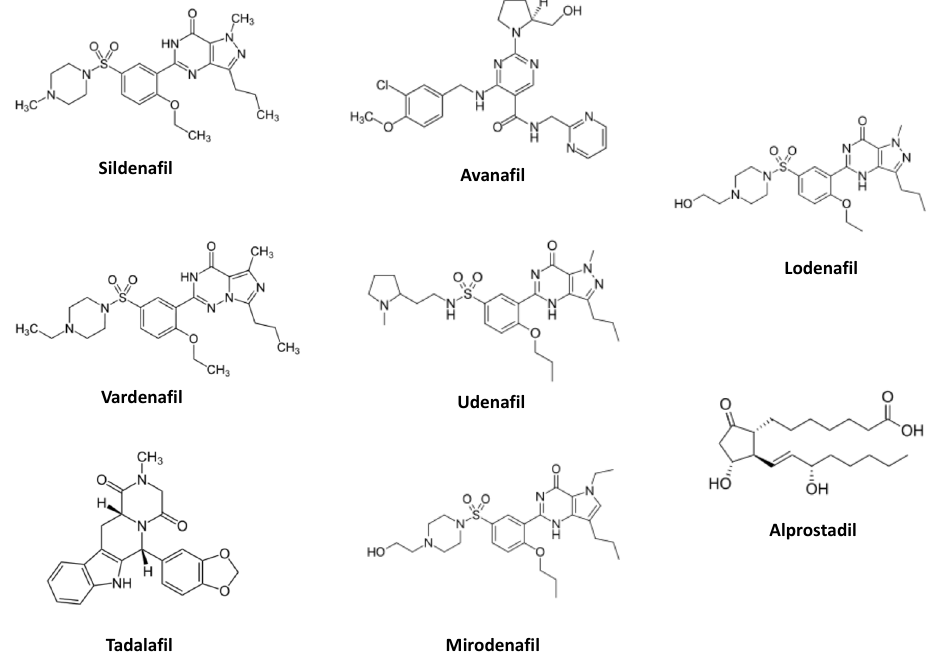
Figure 1. Structural formulas of the vasoactive drugs - phosphodiesterase (PDE)5 inhibitors and alprostadil, a derivative of the natural occurring compound prostaglandin E1)—commonly administered in the pharmacotherapy of male erectile dysfunction (ED). The PDE5 inhibitors share three major domains: a guanine-like purine system, a sugar (ribose)- / phenyl- and a sulphonamide-like entity. Note that the chemical structure of avanafil is significantly different from the standard model.